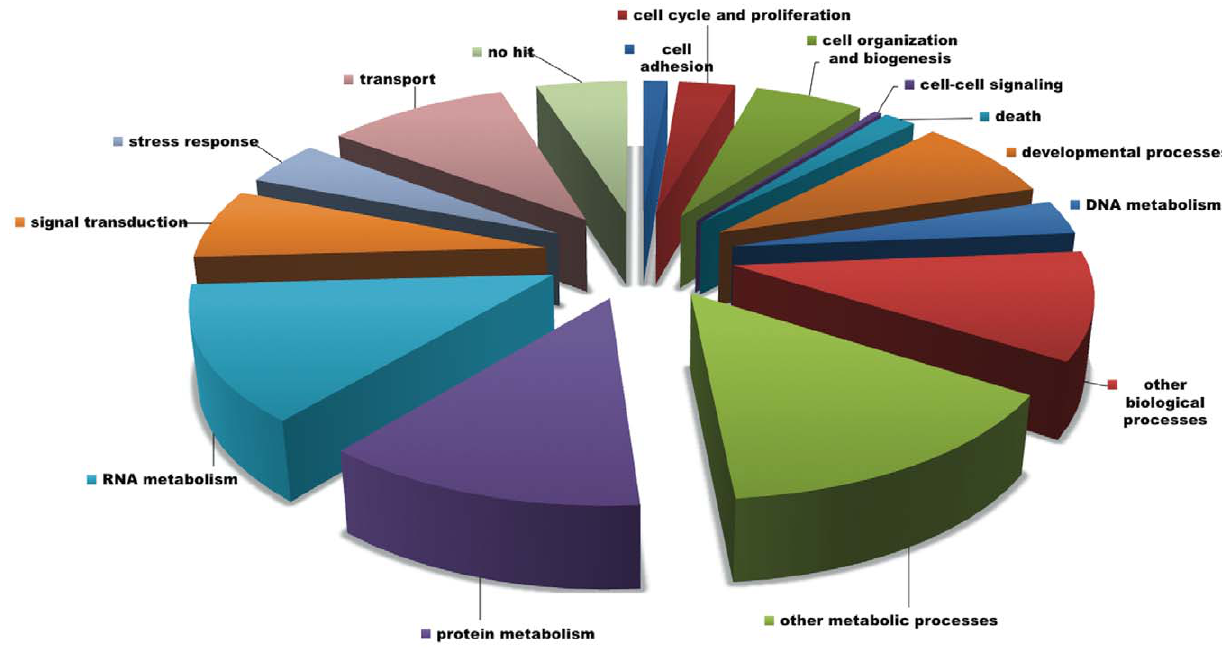
Figure 2. Functional categorization of contig sequences. Contig sequences were generated from de novo assembly of both libraries (n=42,953) and annotations performed using BLASTx with Swiss-Prot and Gene Ontology databases.